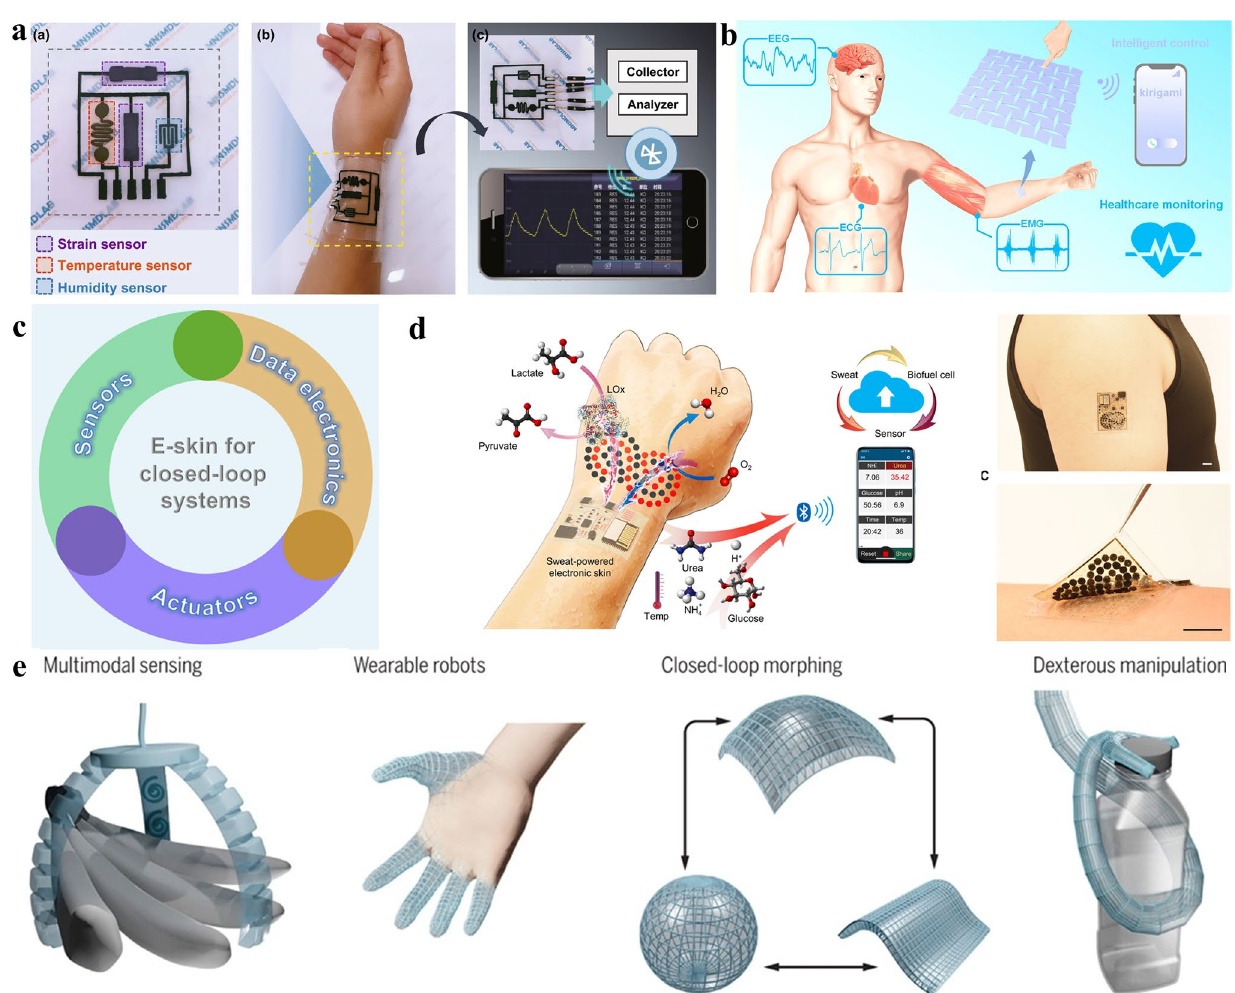
Fig. 6 More multifunctional, integrated, and smarter e‑skin. a Photograph of the e‑skin containing strain sensors, temperature sensor, and humidity sensor. Reproduced with permission from Ref. [94]. Copyright 2021 Springer. b Self‑powered e‑skin for intelligent control. Repro‑ duced with permission from Ref. [95]. Copyright 2022 American Chemical Society. c Closed‑loop e‑skin systems. Reproduced with permission from Ref. [96]. Copyright 2019 American Chemical Society. d Perspiration‑powered e‑skin for multiplexed wireless sensing. Reproduced with permission from Ref. [97]. Copyright 2019 AAAS. e Potential capabilities and technologies that could be achieved with e‑skins. Reproduced with permission from Ref. [8]. Copyright 2020